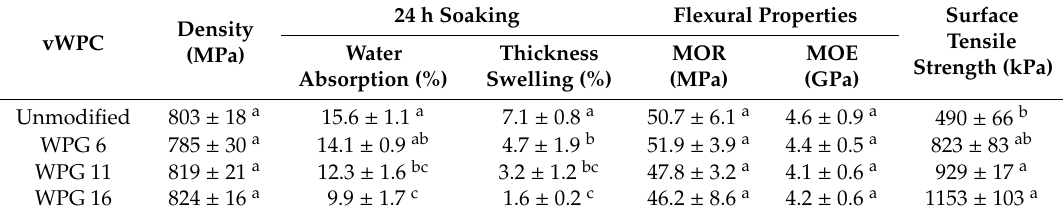
Table 1. E ff ect of acetylated veneers on the physical and flexural properties of vWPCs.